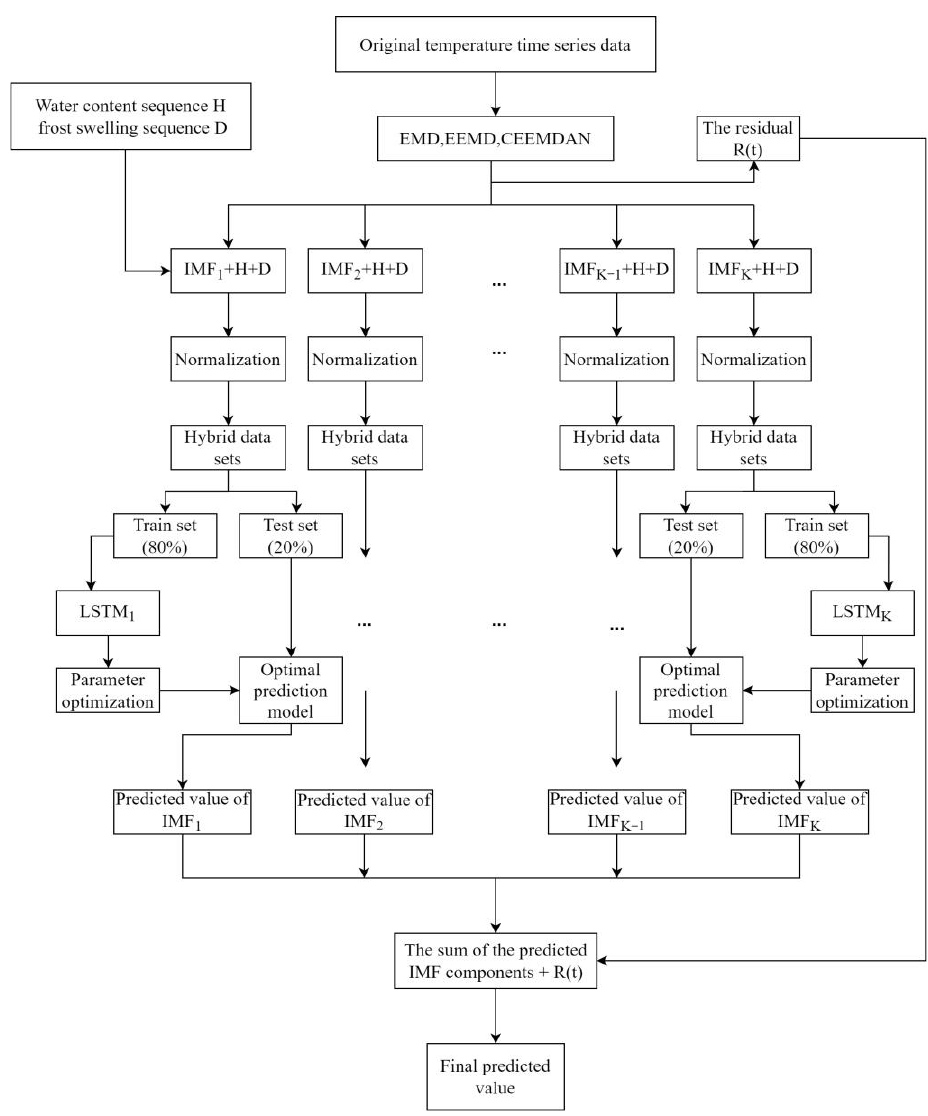
Figure 7. Flow chart of the experiment.